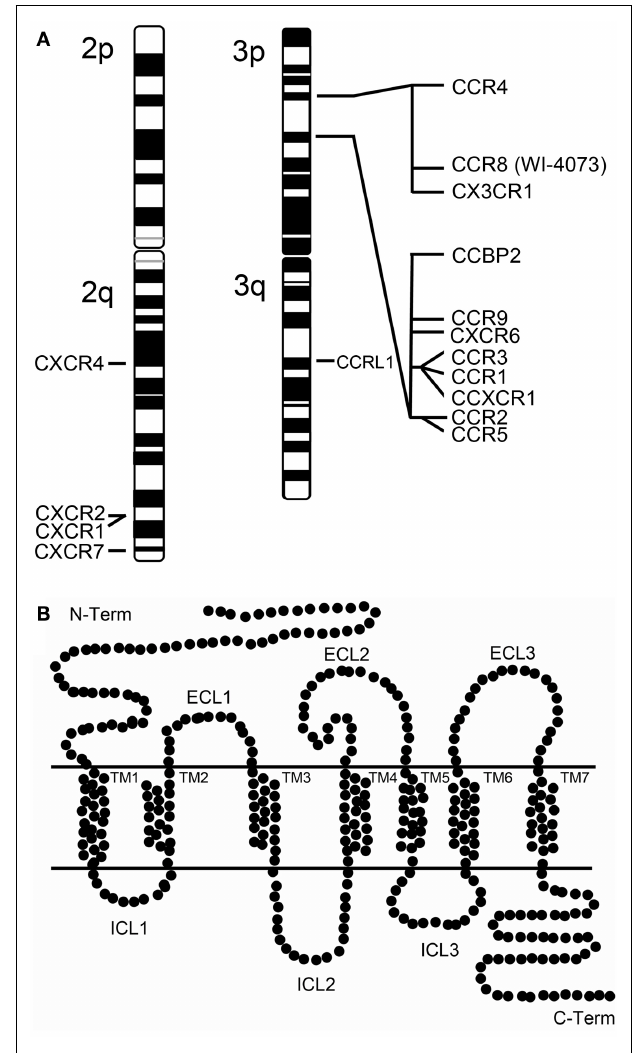
FIGURE 1 | Human chemokine receptors . (A) Chromosomal map of the human chemokine receptor genes at chromosome 2 and 3. Of notice that the chromosome 3p harbors two chemokine receptor clusters. (B) Schematic representation of a chemokine receptor. Chemokine receptors belong to the superfamily of G protein-coupled receptors (GPCRs) which are transmembranar proteins characterized by possessing an extracellular N-terminus and an intracellular C-terminus structure and seven transmembrane α -helices (TM1-TM7) connected extracellularly and intracellularly by six loops (ECL1-ECL3 and